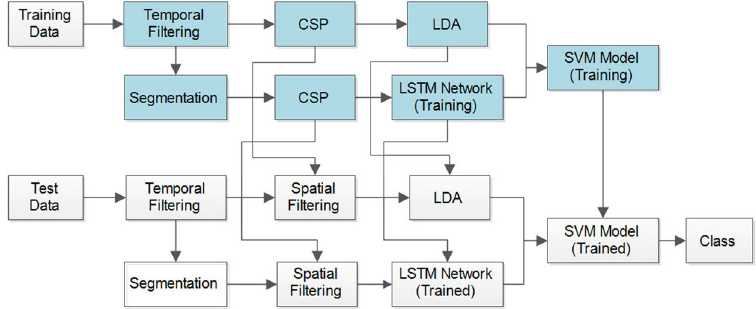
Figure 1. The framework of the proposed predictor, OPTICAL.